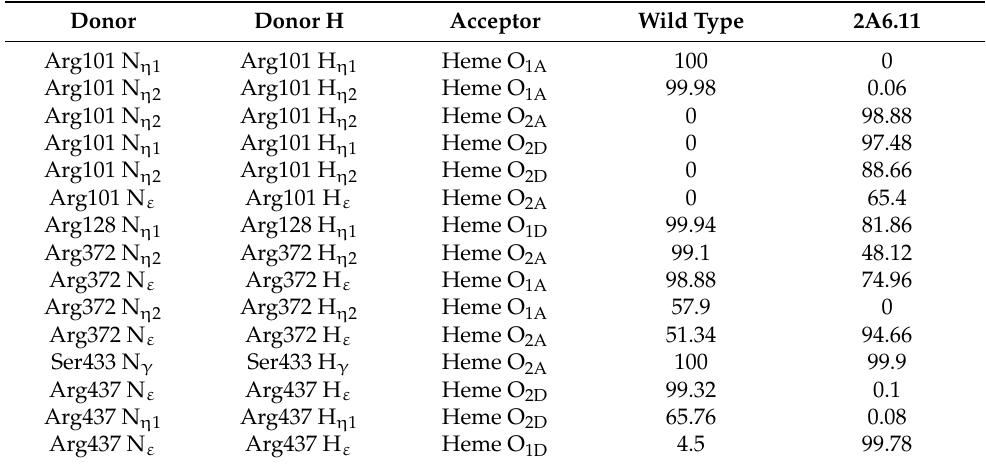
Table 5. Hydrogen bond formation with heme involved in the structural change in